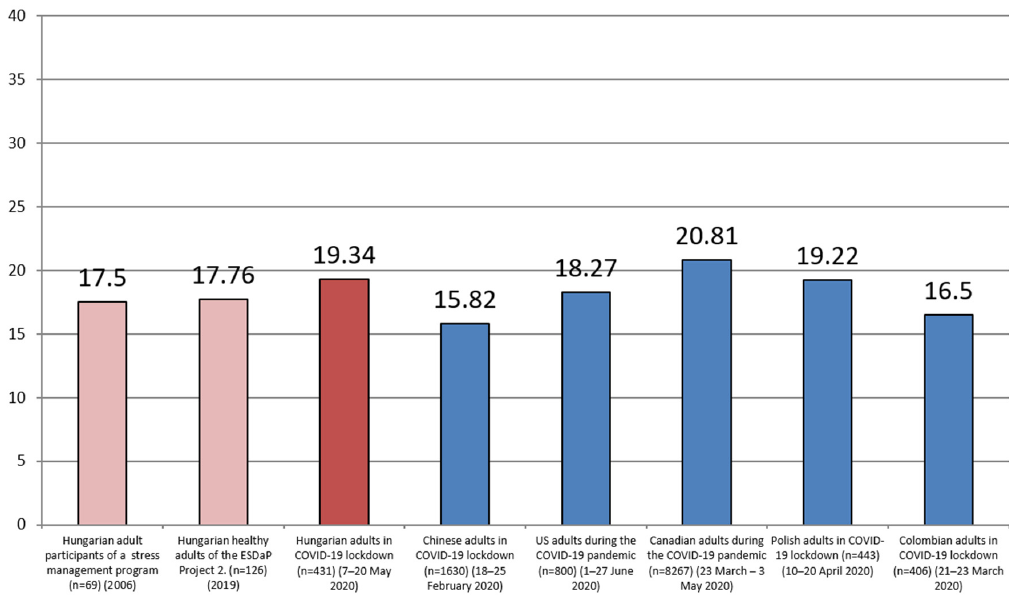
Figure 1. Perceived stress results (measured with the 10 item Perceived Stress Scale) of Hungarian adults ( n = 431) during coronavirus lockdown compared to previous Hungarian scores and other countries’ residents’ scores during the COVID-19 pandemic.